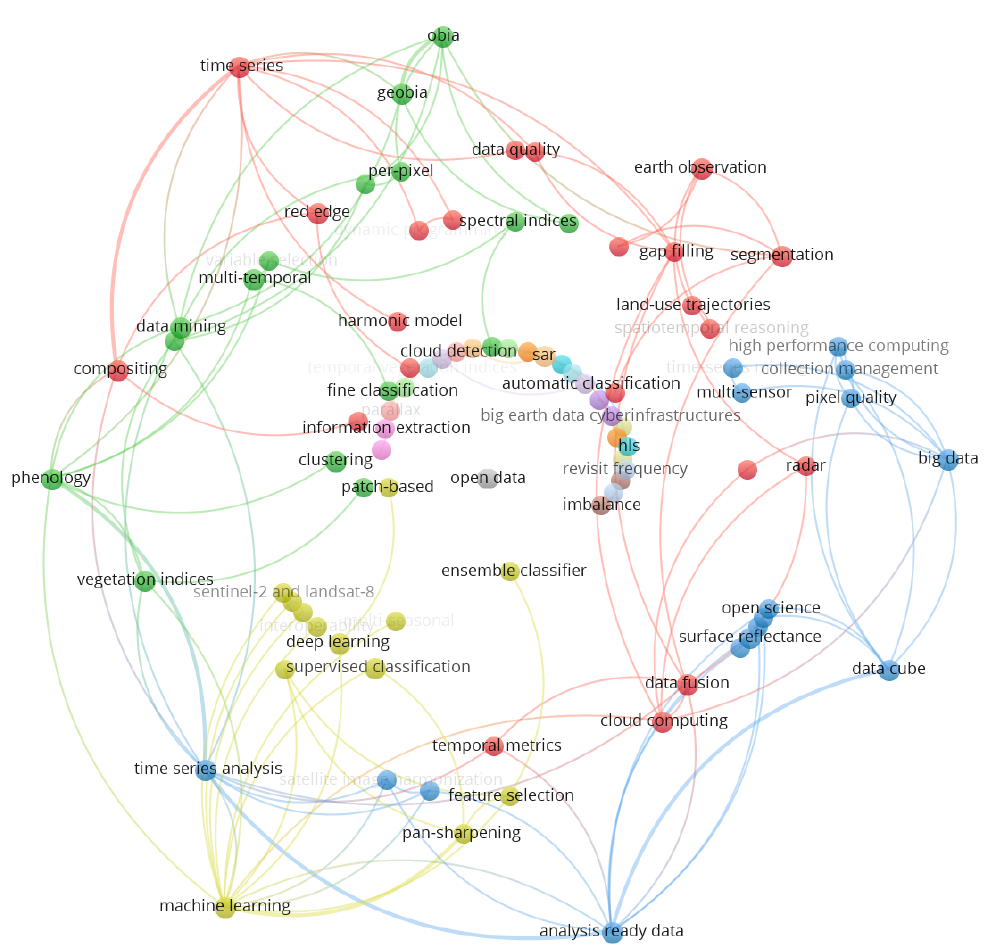
Figure 7. Scientific network mapping of the most used keywords in papers focusing on future possibilities in LULC and LULCC analysis. Colors indicate the cluster in which each keyword was more related. Lines represent co-occurrence link strength among